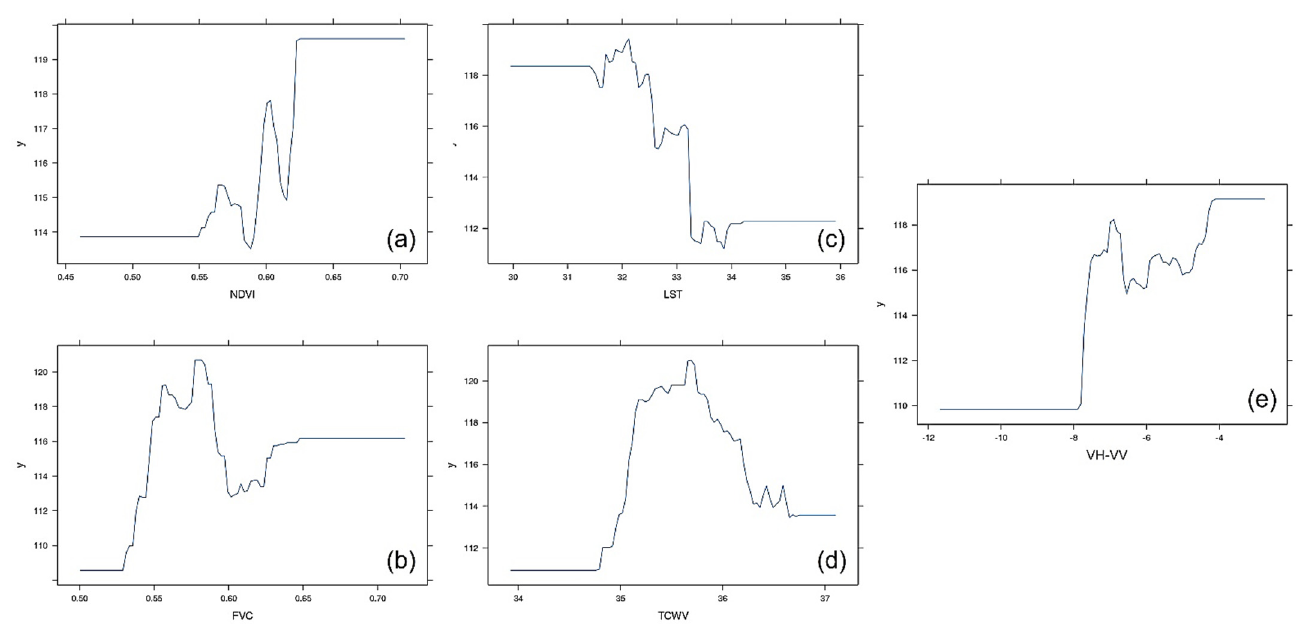
Figure 7. Variation in the AET(y) with the most significant covariates in Busia County: ( a ) NDVI, ( b ) FVC, ( c ) LST, ( d ) TCWV, and ( e ) VH − VV.